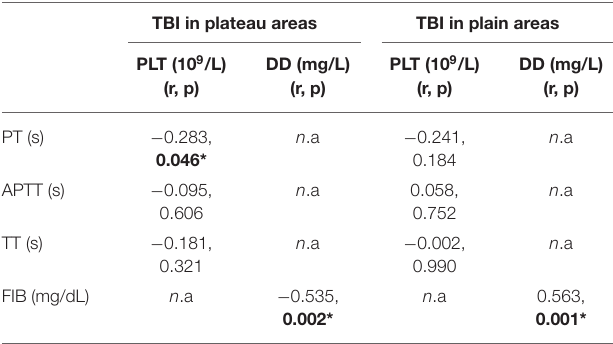
TABLE 3 | Hematology/lipid/coagulation profile of patients with TBI in plateau and plain areas. Variable TBI in plateau TBI in plain T value P value